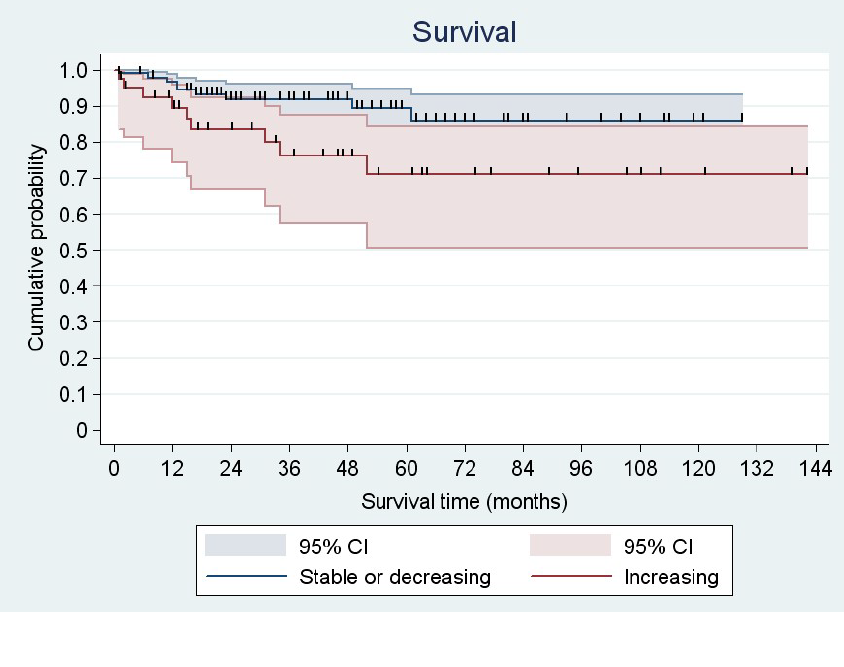
Kaplan-Meier analysis of overall survival after stratification for radiological progression prior to PC-RPLND. Stable or decreasing on imaging overall survival at 5 years 89% (95% CI: 79–95%); Increasing on imaging overall survival at 5 years 71% (95% CI: 51–84%), p = 0.045 for